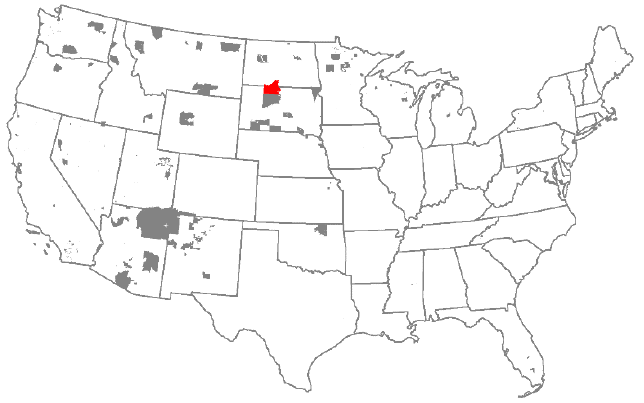
Figure 1. Map of American Indian reservations in the contiguous United States. The Standing Rock Sioux reservation is highlighted in red. Data source: U.S. Census Bureau Federal American Indian Reservations (AIR).